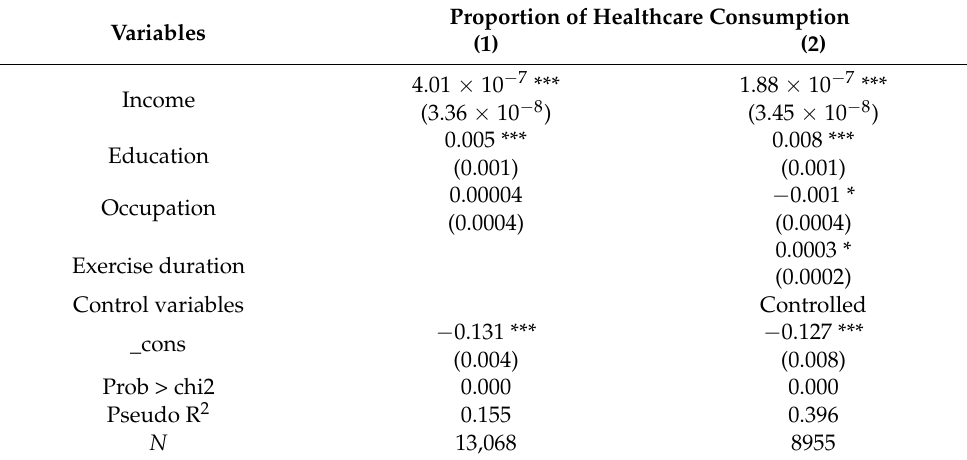
Table 5. Robustness test